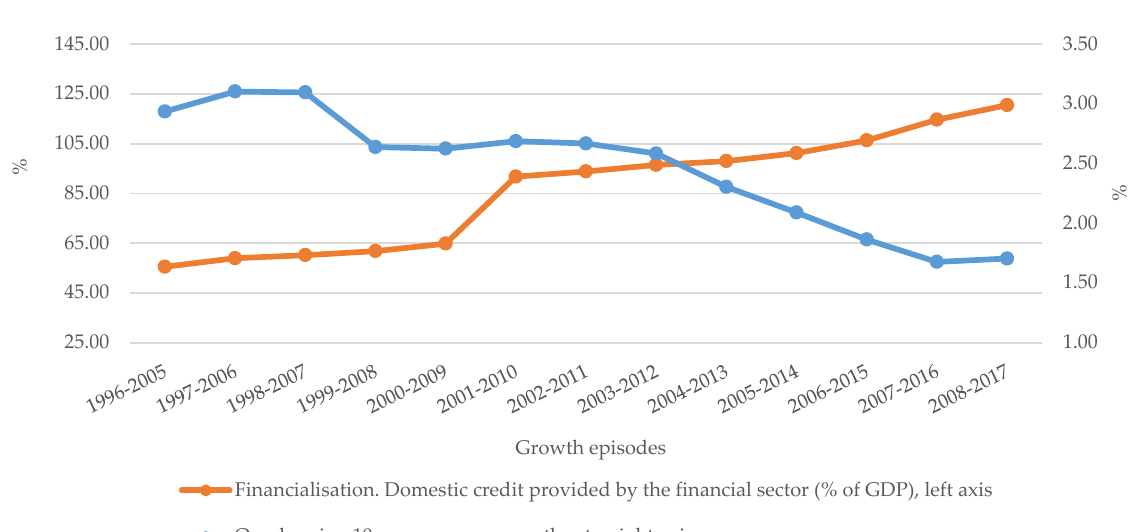
Figure 1. Dynamic of financialisation and long-run economic growth over 1996–2017. Source: all calculations are based on data from The World Bank’s World Development Indicator’s and Governance Indicator’s databases.